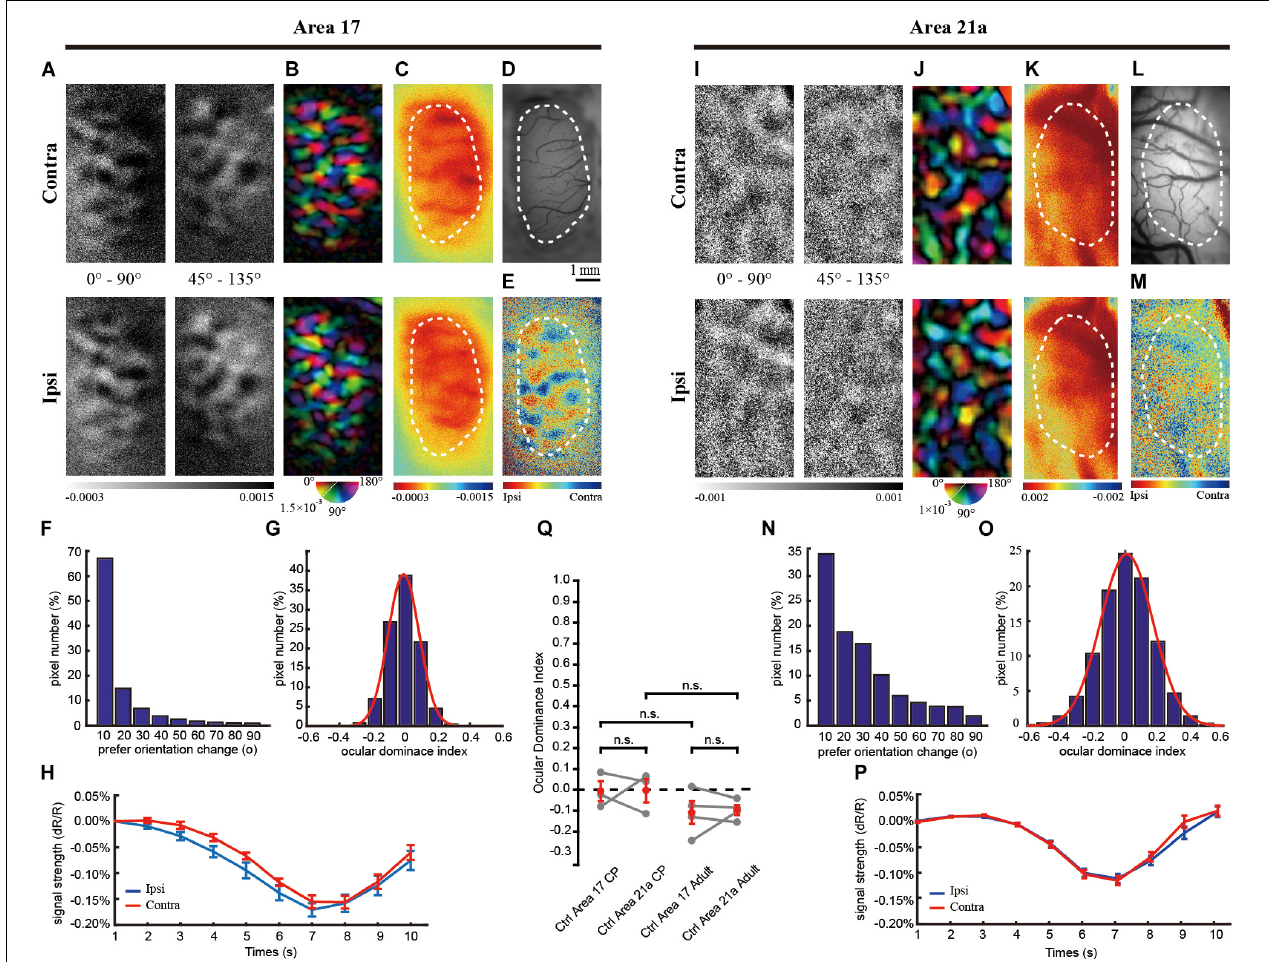
FIGURE 1 | The same-animal comparison between ocular dominance (OD) maps in areas 17 (A – H) and 21a (I – P) in normal cats ( A – P are from one typical cat, and Q illustrates data pairs of area 17 and area 21 from multiple animals). (A,I) Each row shows orientation differential maps evoked by monocular stimuli. Top: contralateral eye (contra). Bottom: ipsilateral eye (ipsi). Each column shows orientation differential maps with varying- orientation stimuli. Left: 0–90 ◦ . Right: 45–135 ◦ . (B,J) Orientation tuning is visualized by orientation polar maps, in which different colors represent the preferred stimulus orientation, and the gray scale represents the tuning strength of each pixel. Top: contralateral eye. Bottom: ipsilateral eye. (C,K) Global signal maps showing the averaged cortical response to stimuli with all orientations. Top: contralateral eye. Bottom: ipsilateral eye. (D,L) Blood vessel map. Scale bars: 1 mm. (E,M) OD maps of area 17 and area 21a. Red regions of the OD map represent domains dominated by the ipsilateral eye, and blue regions represent domains dominated by the contralateral eye. (F,N) The distribution of pixelwise differences of preferred orientation between the two eyes. (G,O) The distribution of the ocular dominance index (ODI) of pixels in the dashed regions in (E,M) , respectively. (H,P) The time course of the global signals in area 17 and area 21a for the two eyes. Each global signal represents the mean of all the pixels in the region of interest (ROI) (shown as dotted region in C or K ). (Q) Statistical analysis of ODI in control animals. The mean ODI of all the pixels in the ROI was calculated as the ODI of this cortical area and shown as one individual point. N = 3 kittens during the critical period (CP) and n = 4 adult animals. Note that both area 17 and area 21a were imaged from the same animal, and the data points from the same animal are connected with lines. Data are the means ± SEM; paired-sample and two-sample t -tests: n.s., not